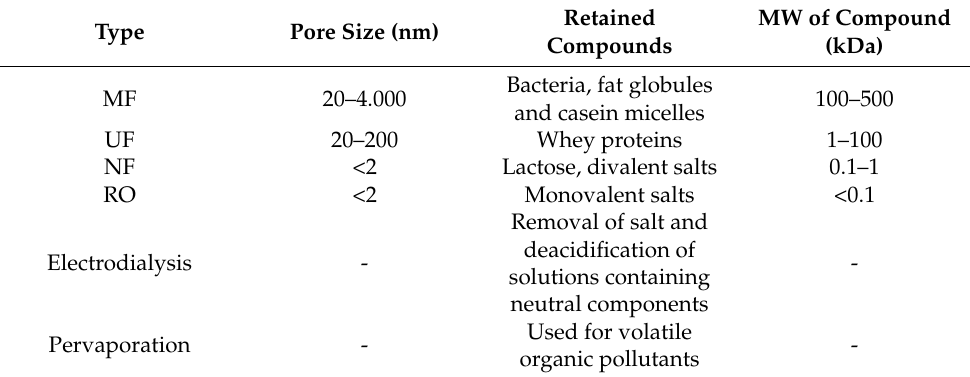
Figure 4. Membrane separation processes used to process CW and SCW. Table 5. Comparison of membrane separation of milk